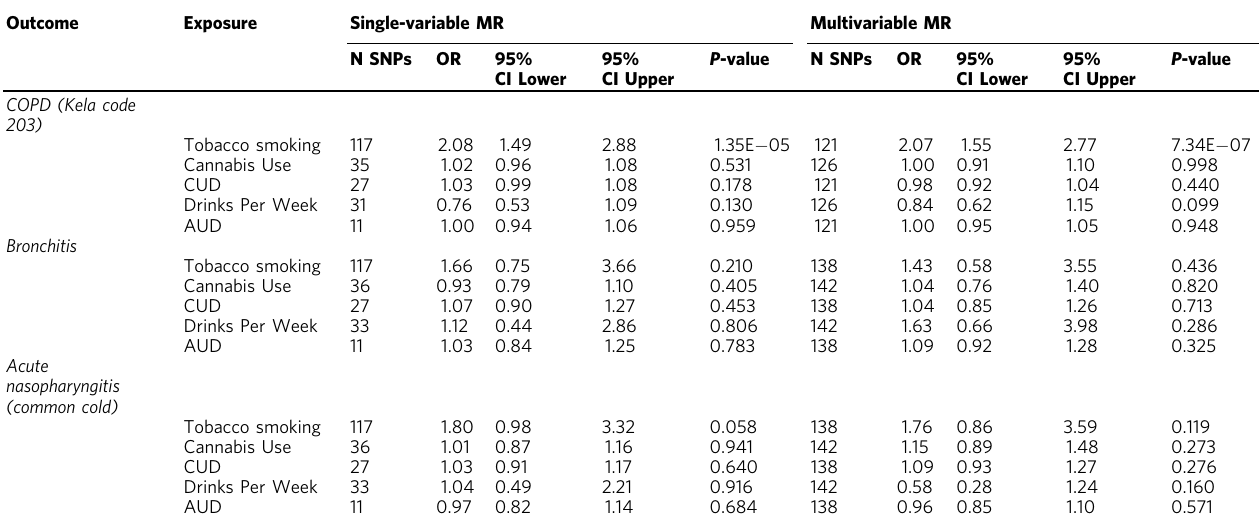
Table 3 Single variable and multivariable MR results of the genetic liability of alcohol, cannabis and lifetime smoking exposures on chronic obstructive pulmonary disorder, bronchitis, and the common cold. Outcome Exposure